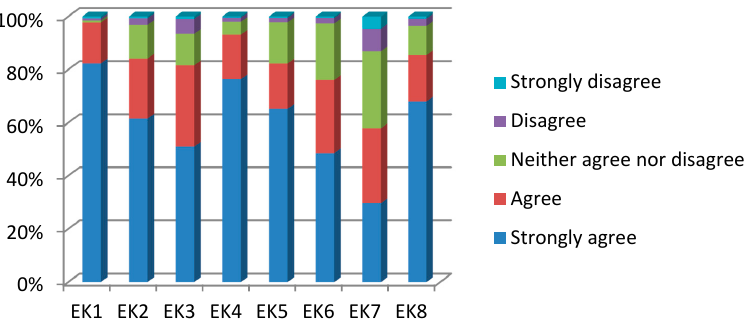
Figure 3. Frequency distribution of the indicators of Environmental knowledge . Notes : EK1: Jinchuan suffers from air pollution. EK2 : Jinchuan suffers from industrial solid waste. EK3 : Jinchuan suffers from water pollution. EK4 : Environmental issues in Jinchuan are mainly caused by local industrial activities. EK5 : Sulfur dioxide is one of the main air pollutants of Jinchuan. EK6 : Suspended particles is one of the main air pollutants of Jinchuan. EK7 : Carbon dioxide is one of the main air pollutants of Jinchuan. EK8 : Chlorine gas is one of the main air pollutants of Jinchuan. Source: Author’s